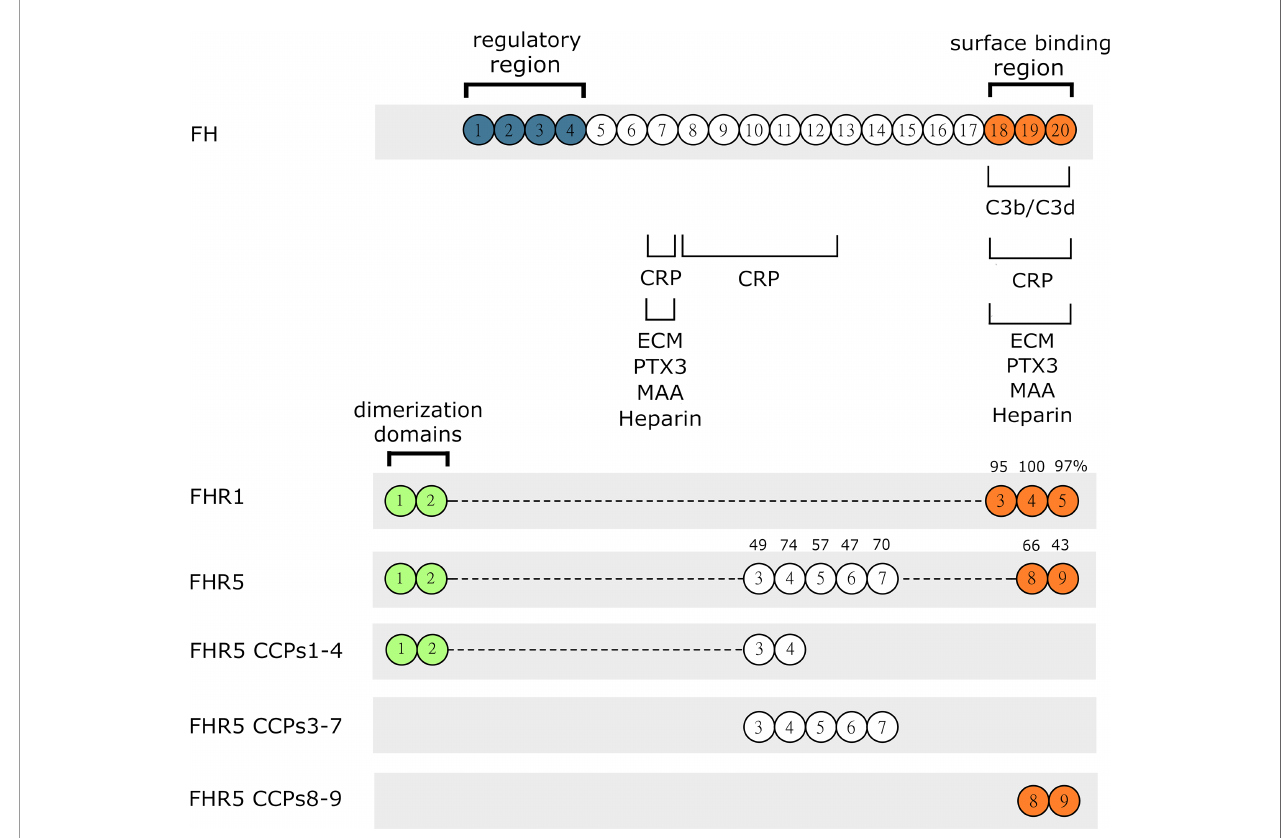
FIGURE 1 | Schematic drawing of FH, FHR1, FHR5 and the recombinant FHR5 fragments used in this study. FH, FHR1 and FHR5 are composed of individually folding globular domains called complement control protein domains (CCPs) or also known as short consensus repeats (SCRs). CCPs 1-4 of FH mediate complement regulatory activity while the CCPs 7 and 18-20 are responsible for binding different ligands and surface recognition. The CCPs of FHR1 and FHR5 share high amino acid sequence identity with the corresponding domains of FH, indicated by numbers above. The C-terminal part is well conserved indicating similar or identical ligand and surface binding between FHR1, FHR5 and FH. FHR proteins lack the N-terminal regulatory domains CCPs 1-4 of FH. CCPs 1-2 of FHR1 and FHR5 are very similar to each other and responsible for formation of homo and